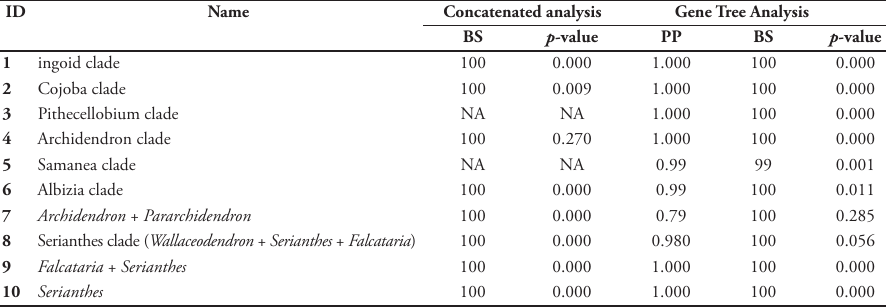
Table 3. Comparison of support values for individual nodes from concatenated analysis vs. gene tree analysis. BS and p- value (polytomy test) generated by concatenated analysis. BS, PP and p- value (poly- tomy test) generated by gene tree